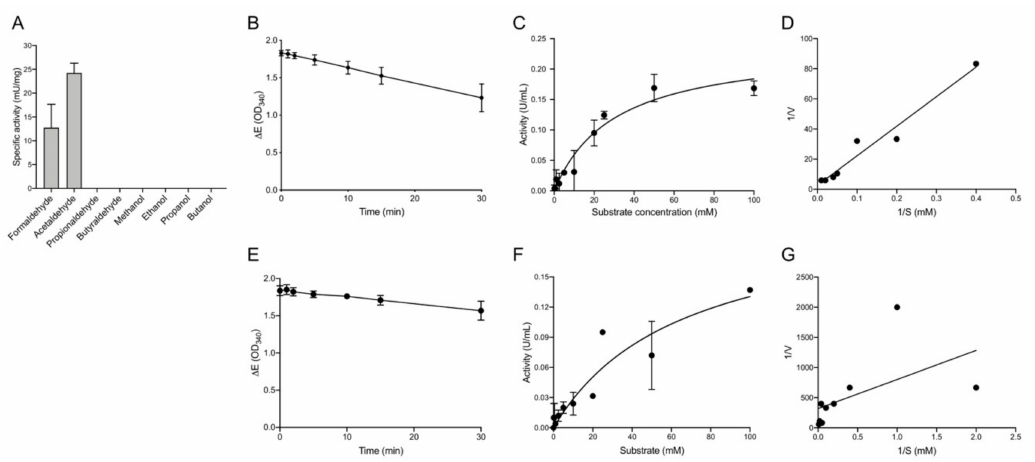
Figure 4. Determination of the enzymatic activity of recEhADH3B b . ( A ). The catalytic activity of recEhADH3B b was determined with a range of substrates (formaldehyde (50 mM), acetaldehyde (20 mM), propionaldehyde and butyraldehyde, methanol, ethanol, propanol, butanol (all 100 mM)) in the presence of 0.7 mM NADP(H) at pH 7.4. ( B–D ) Enzyme kinetic of recEhADH3B b using acetaldehyde as substrate. ( E , F ) Enzyme kinetic of recEhADH3B b using formaldehyde as substrate. ( B , E ) Time dependence of enzymatic activity; ( C , F ) Michaelis-Menten plot; ( D , G ) Lineweaver–Burk plot.